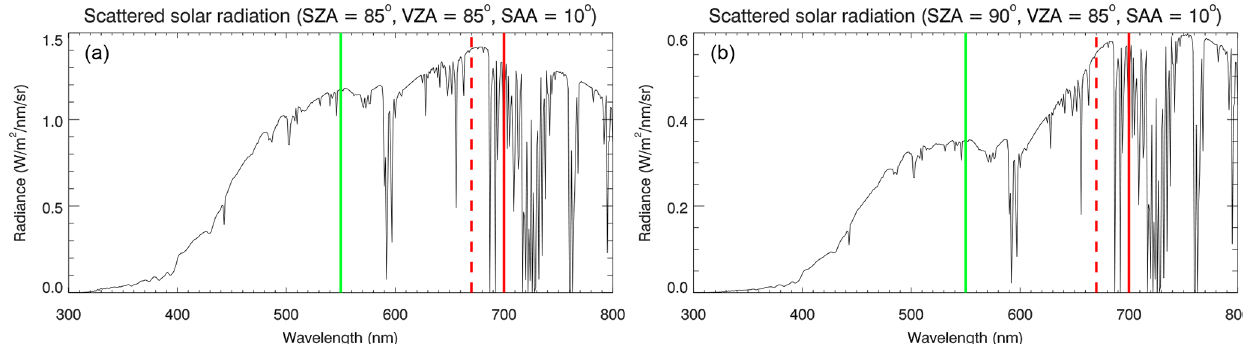
Figure 3. Sample spectra of scattered solar radiation for SZAs of 85 ◦ (a) and 90 ◦ (b) and the following parameters: VZA = 85 ◦ , SAA = 10 ◦ , TOC = 300DU, A S = 0 . 3, AOD = 0 . 1, r med = 250nm, and S = 1 . 5. The solid green and red lines indicate wavelengths of 550 and 700nm, while the dashed red line corresponds to 670nm.